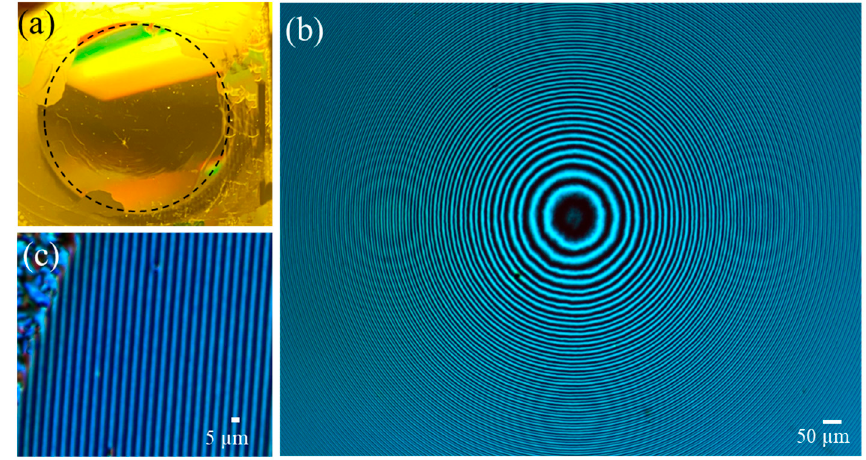
Figure 3. ( a ) Photograph of the fabricated PB lens. The diameter is ~1.7 cm. Polarizing optical microscope images of the large optical power PB lens ( b ) at the central area, and ( c ) at the margin.